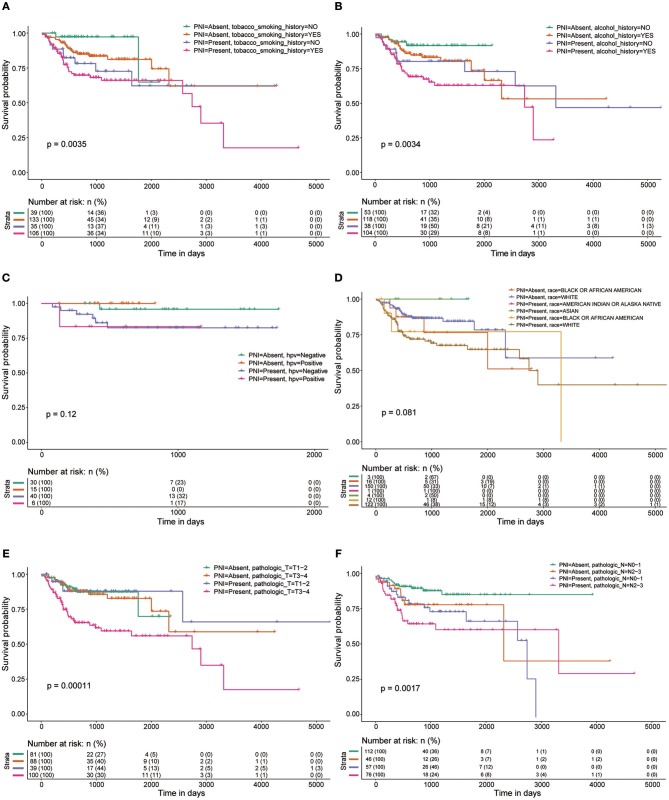
OS rates of patients with and without PNI were compared with regards to (A) smoking history, (B) alcohol history, (C) HPV status, (D) race, (E) pathologic T category, and (F) pathologic N category.